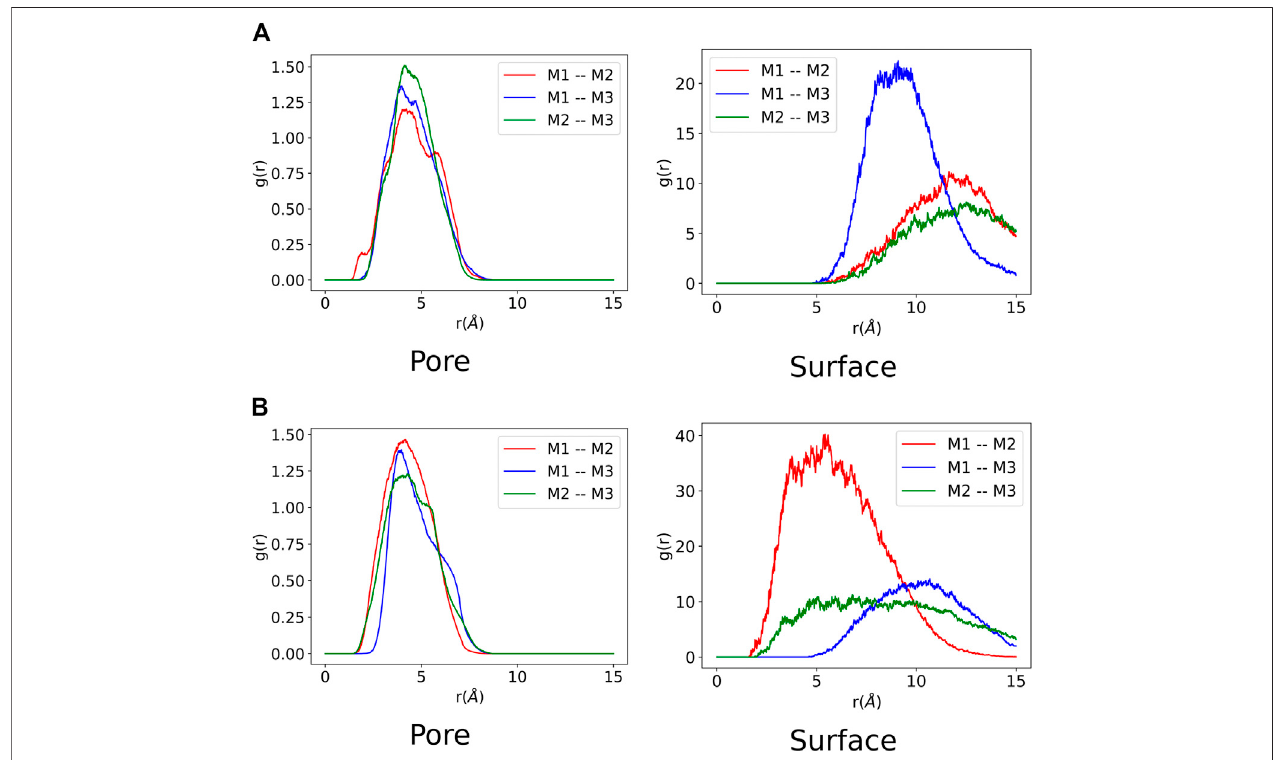
FIGURE 6 | Monomer-monomer radial distribution function from each molecular dynamic trajectory composed of three monomers. Each monomer is labelled M i (i (cid:1) 1,2or 3).Thelabels ” Pore ” and ” Surface ” correspondtointeractionsatthenanochannelandsurfacerespectively. (A) EDOT-EDOTradialdistributionfunction at nanochannel and surface of ZnPW. (B) Styrene-styrene radial distribution function at nanochannel and surface of ZnPW.